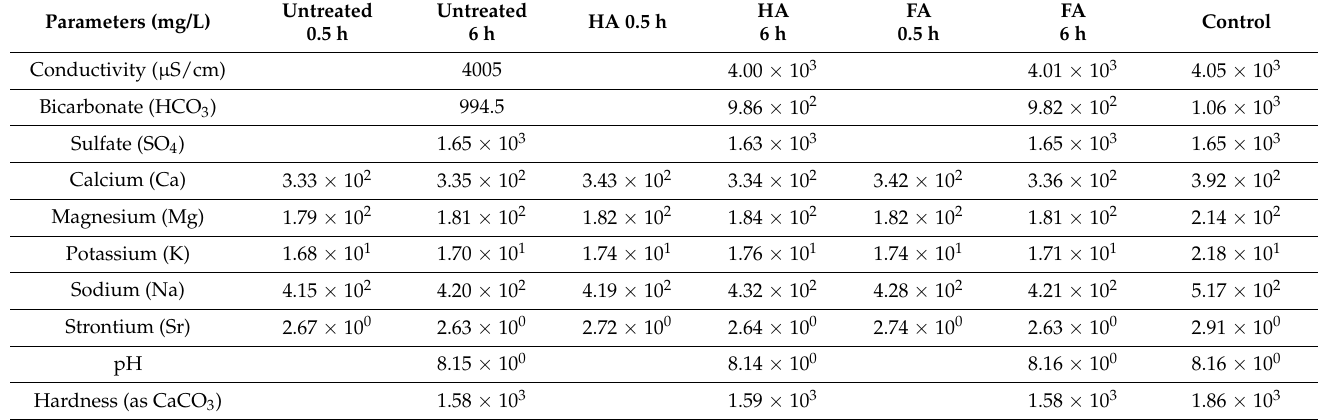
Table 8. Average water quality collection from time-series WTP wastewater experiments with pyrolusite media. Duplicate samples were collected from beakers containing untreated pyrolusite, as well as HA- and FA-pretreated pyrolusite media. Water quality results for the control sample (containing no pyrolusite) are also provided. All water quality analyses were performed by a certified analytical